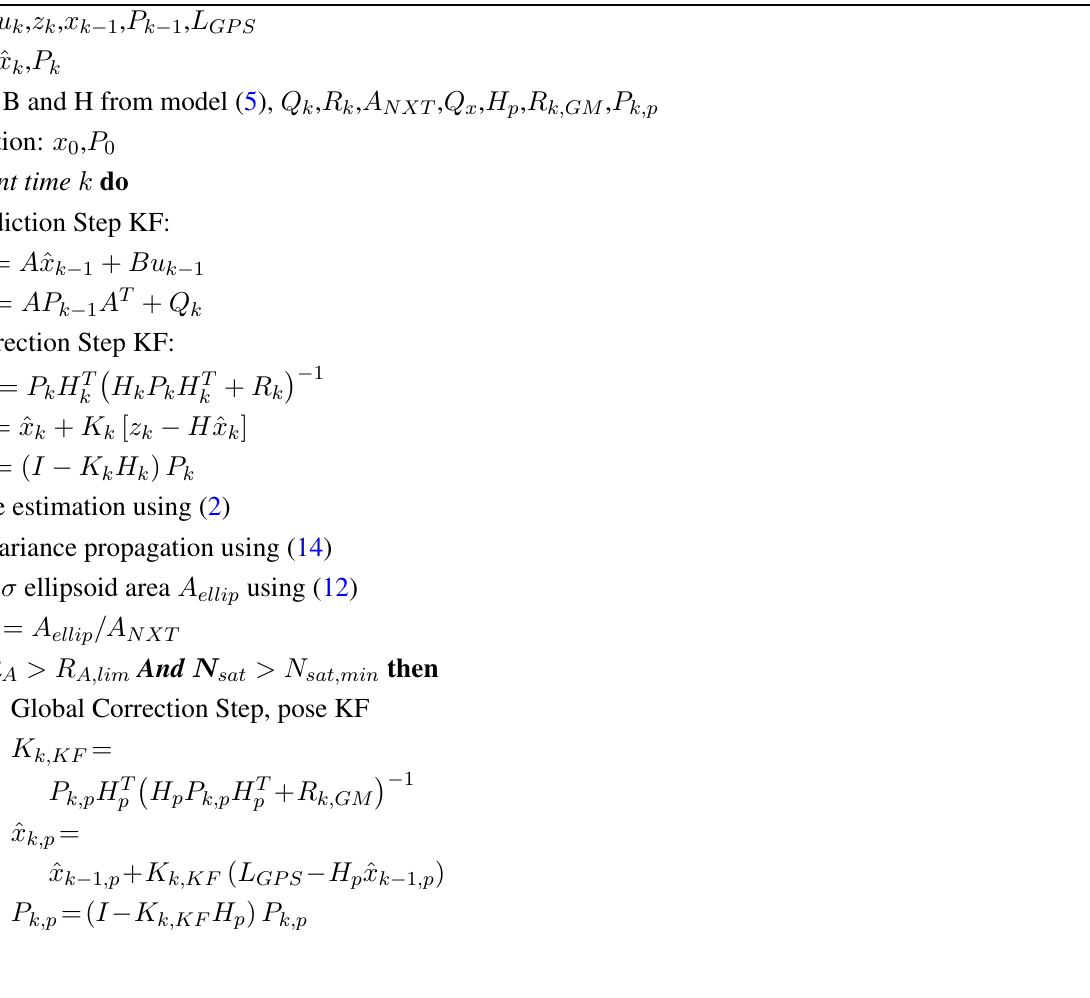
Algorithm 3: Event based KF, Ackermann